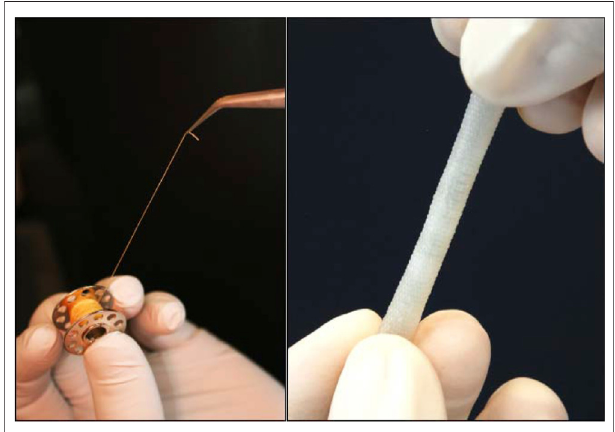
FIGURE 7 | A thread (left) and a woven vessel (right) made from human Cell-assembled Extracellular Matrix [modi fi ed from (L ’ Heureux, 2020)].